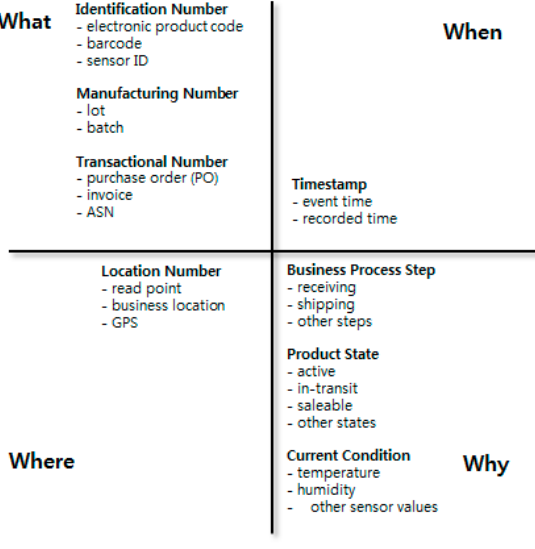
Figure 1. Four dimensions of traceability data.